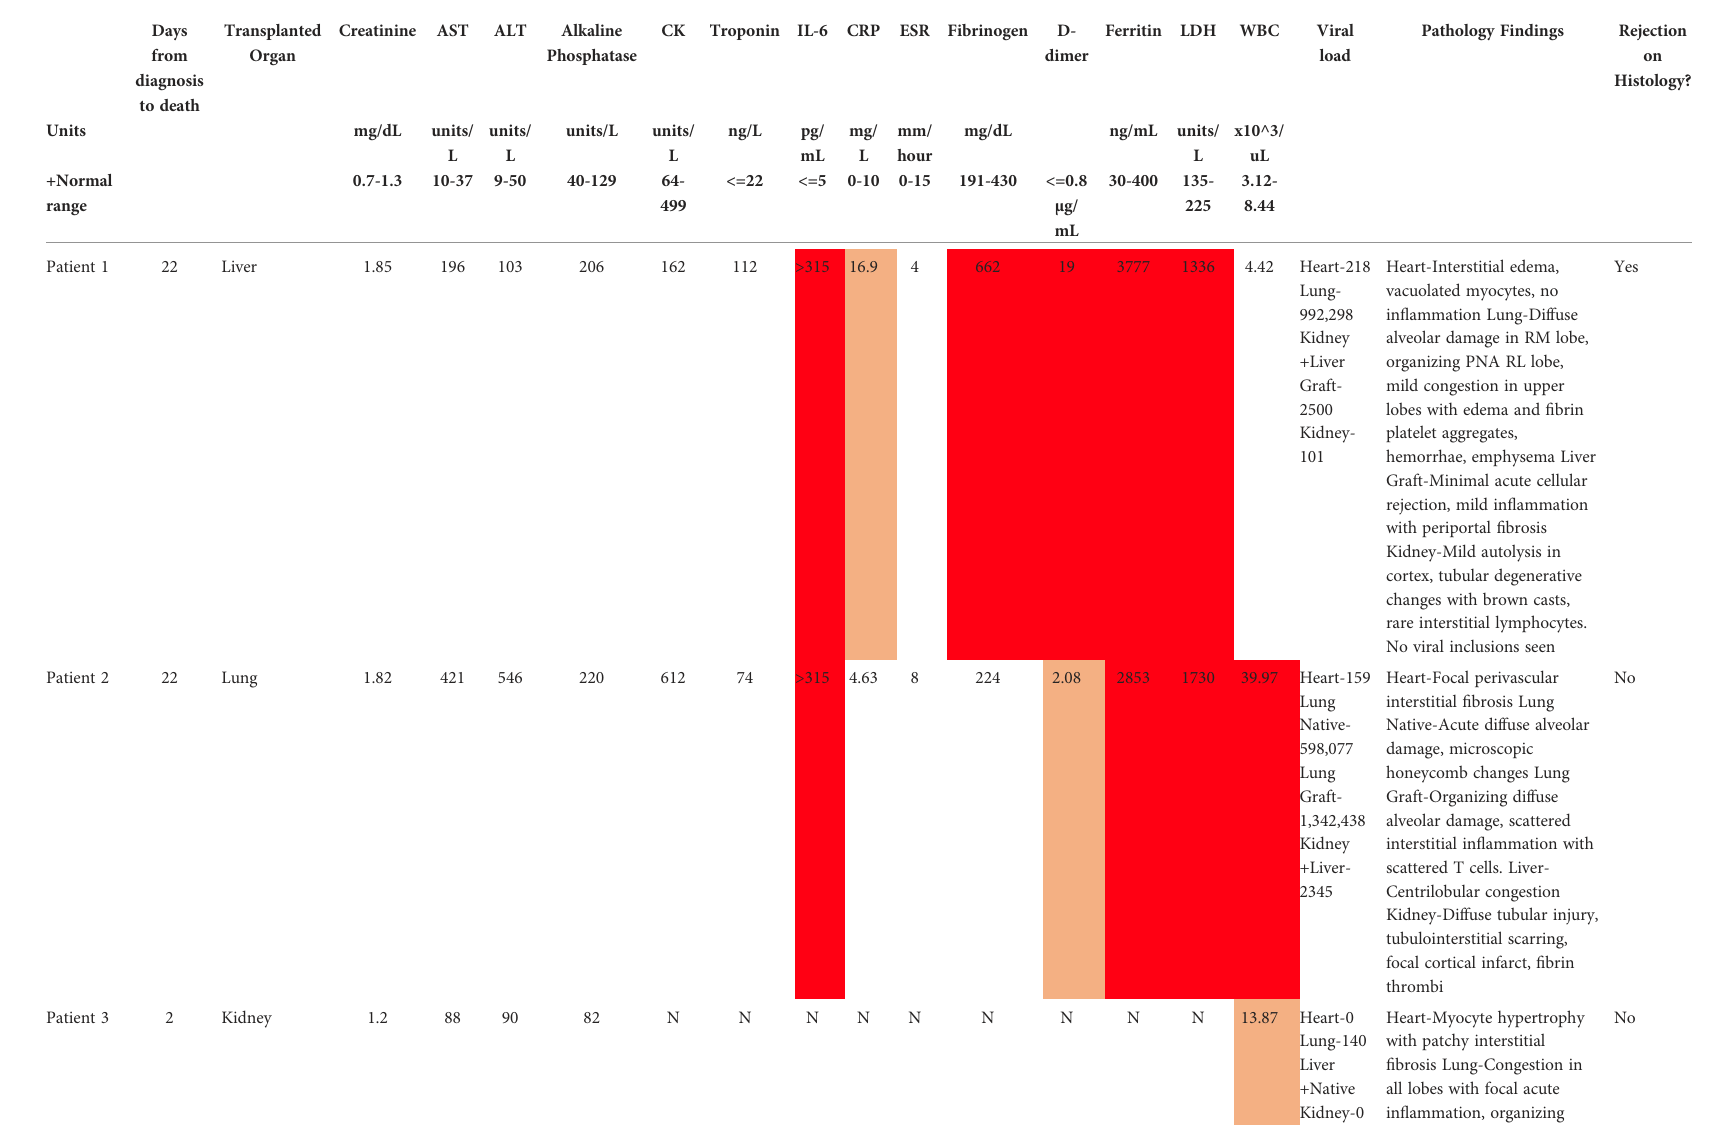
TABLE 2 Patient Findings During SARS-CoV-2